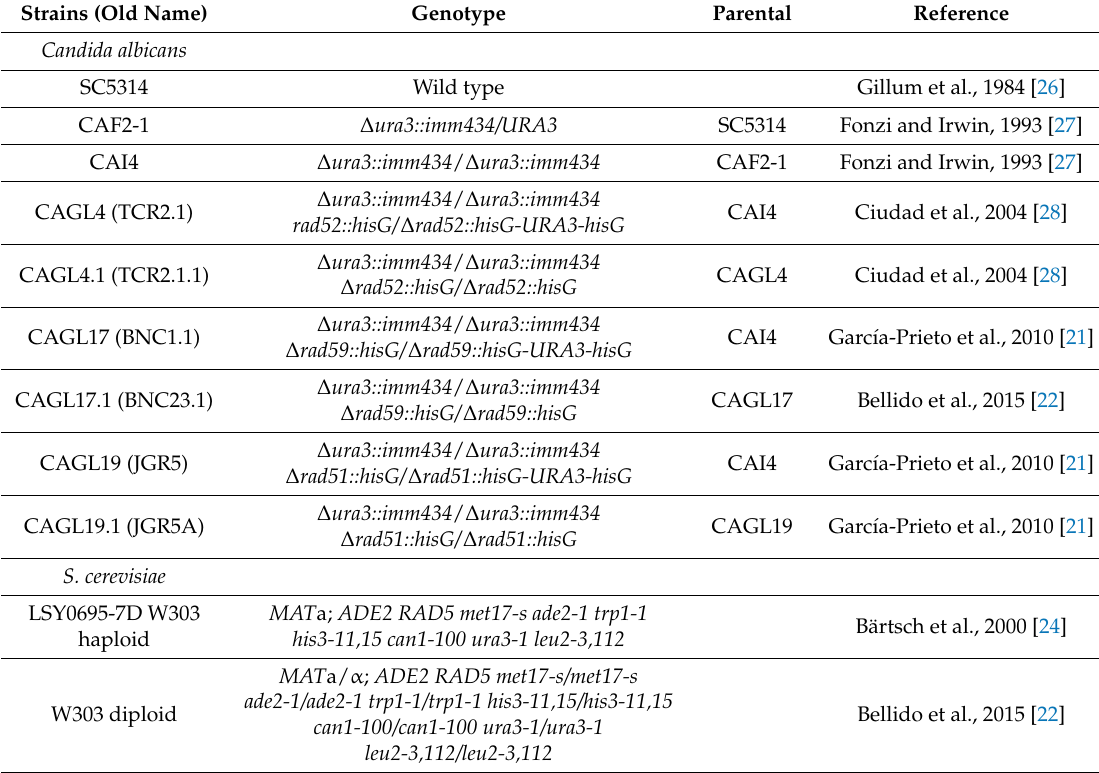
Table 1. Strains used in this